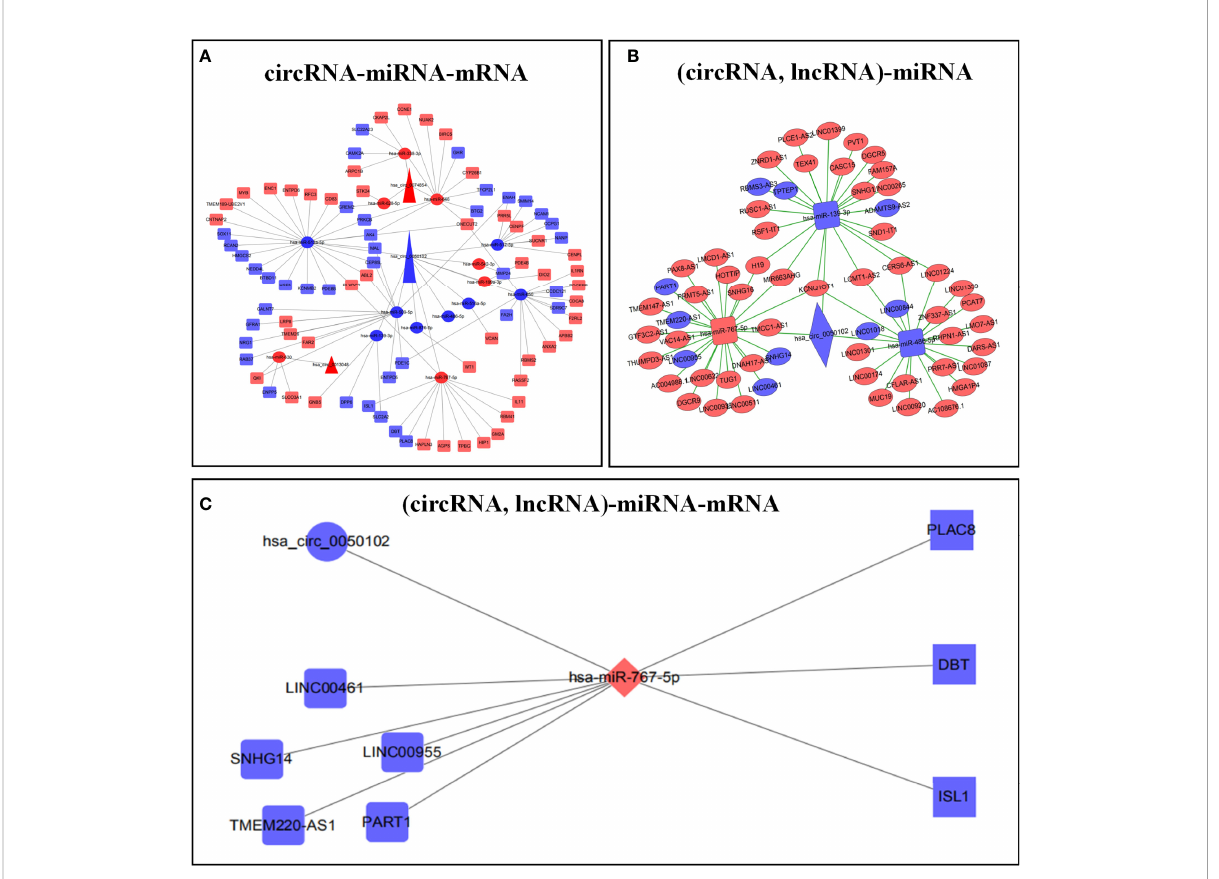
FIGURE 2 Construction of ceRNA prognostic models. circRNA-miRNA-mRNA regulatory network (A) . (circRNA, lncRNA)-mRNA regulatory network (B) . (circRNA, lncRNA)-miRNA-mRNA regulatory network (C) . Red represents up regulation, blue represents down